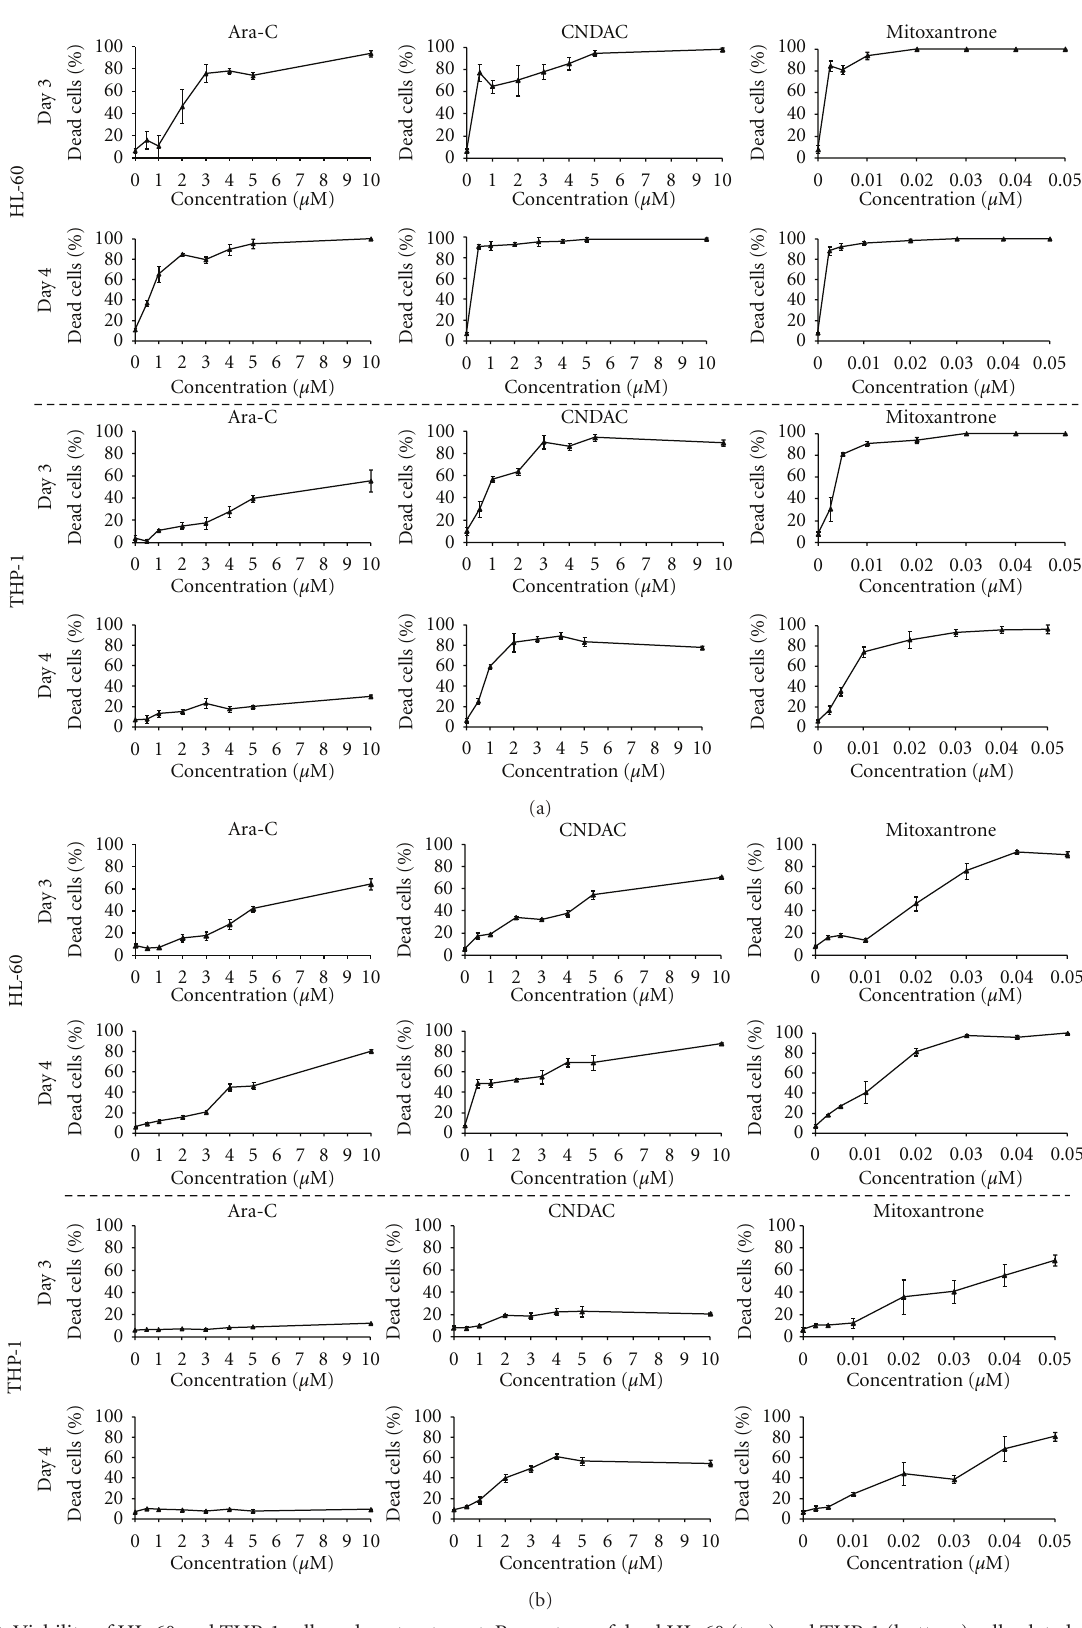
Figure 2: Viability of HL-60 and THP-1 cells ± drug treatment. Percentage of dead HL-60 (top) and THP-1 (bottom) cells plated at (a) 0.05 × 10 6 cells/mL and (b) 0.5 × 10 6 cells/mL. Cells were treated with ara-C, CNDAC, and mitoxantrone in triplicate; data shown is from drug treatments for 3 and 4